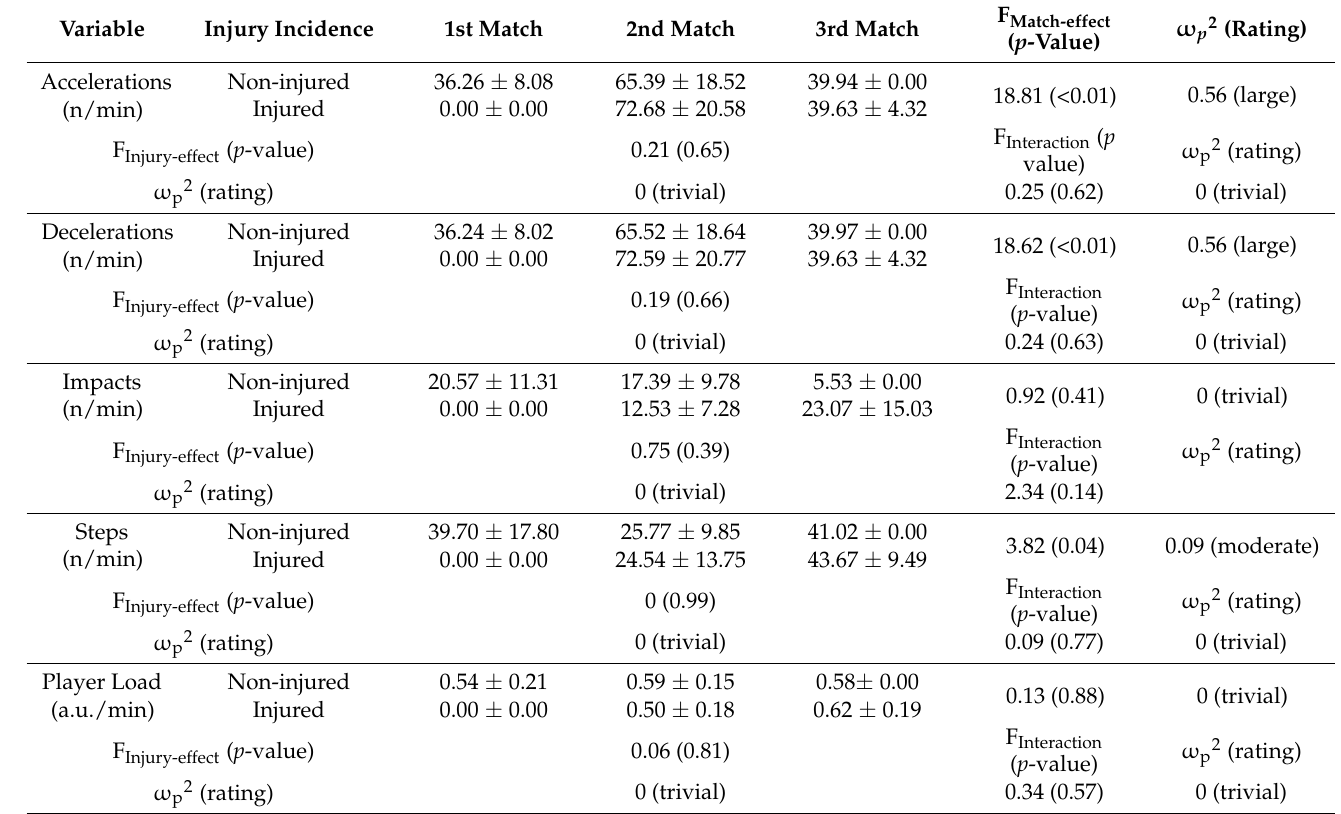
Table 5. Raw data of mechanical workload variables by match and injury